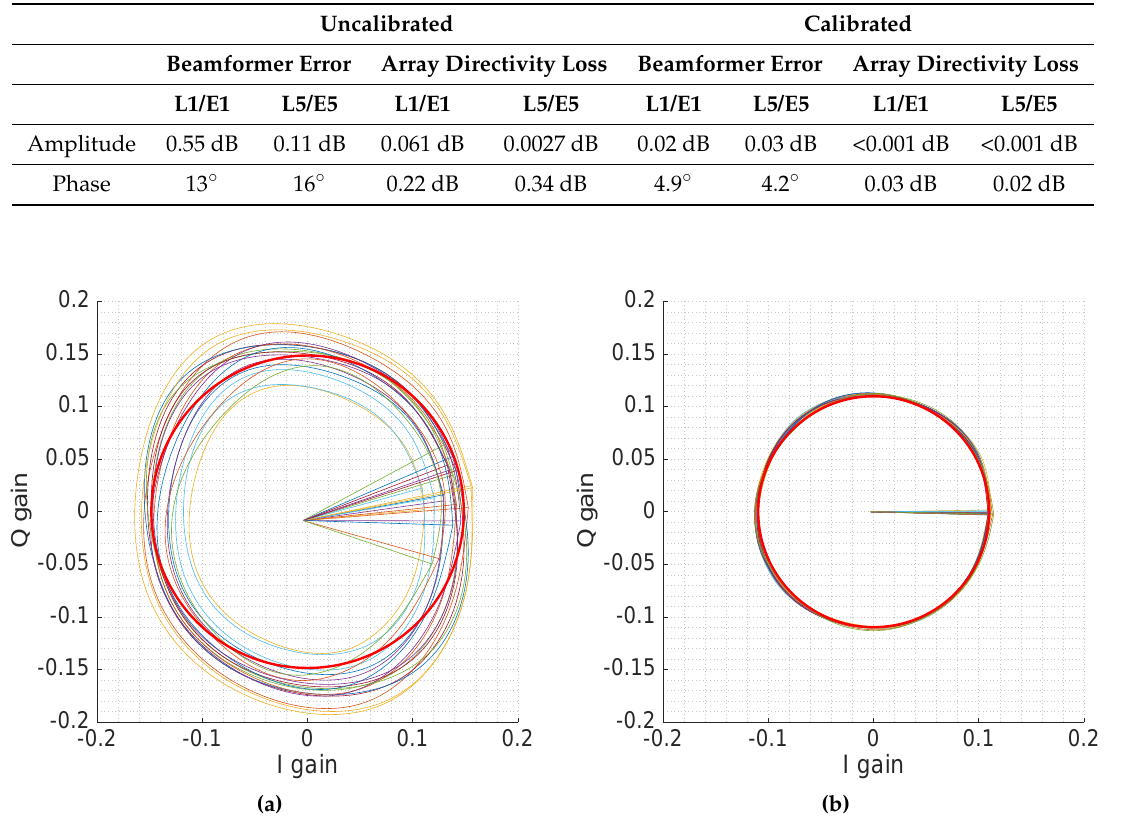
Figure 19. IQ gain circles before ( a ) and after calibration ( b ). The radii lines mark where the circle starts to “rotate”. A red circle with average radius has been added to ease the viewing the effect of the amplitude